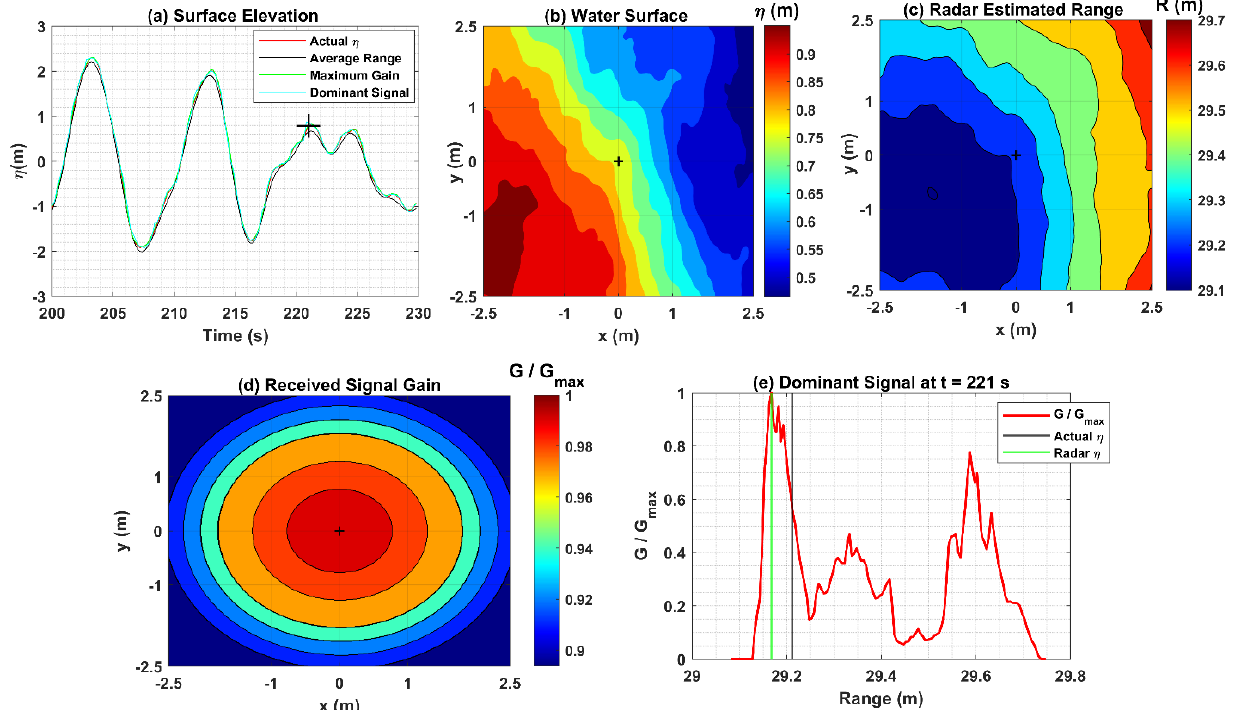
Figure 10. Radar dominant signal processing for a crest elevation of 0.78 m which occurred at time step of 221 s: ( a ) time series plots of actual surface elevations and that from the Radar signals; ( b ) water surface covered by the Radar footprint (5 m × 5 m); ( c ) Radar estimated ranges over its footprint; ( d ) normalized received signal gain over the Radar footprint; ( e ) normalized dominant signal gain as a function of range.